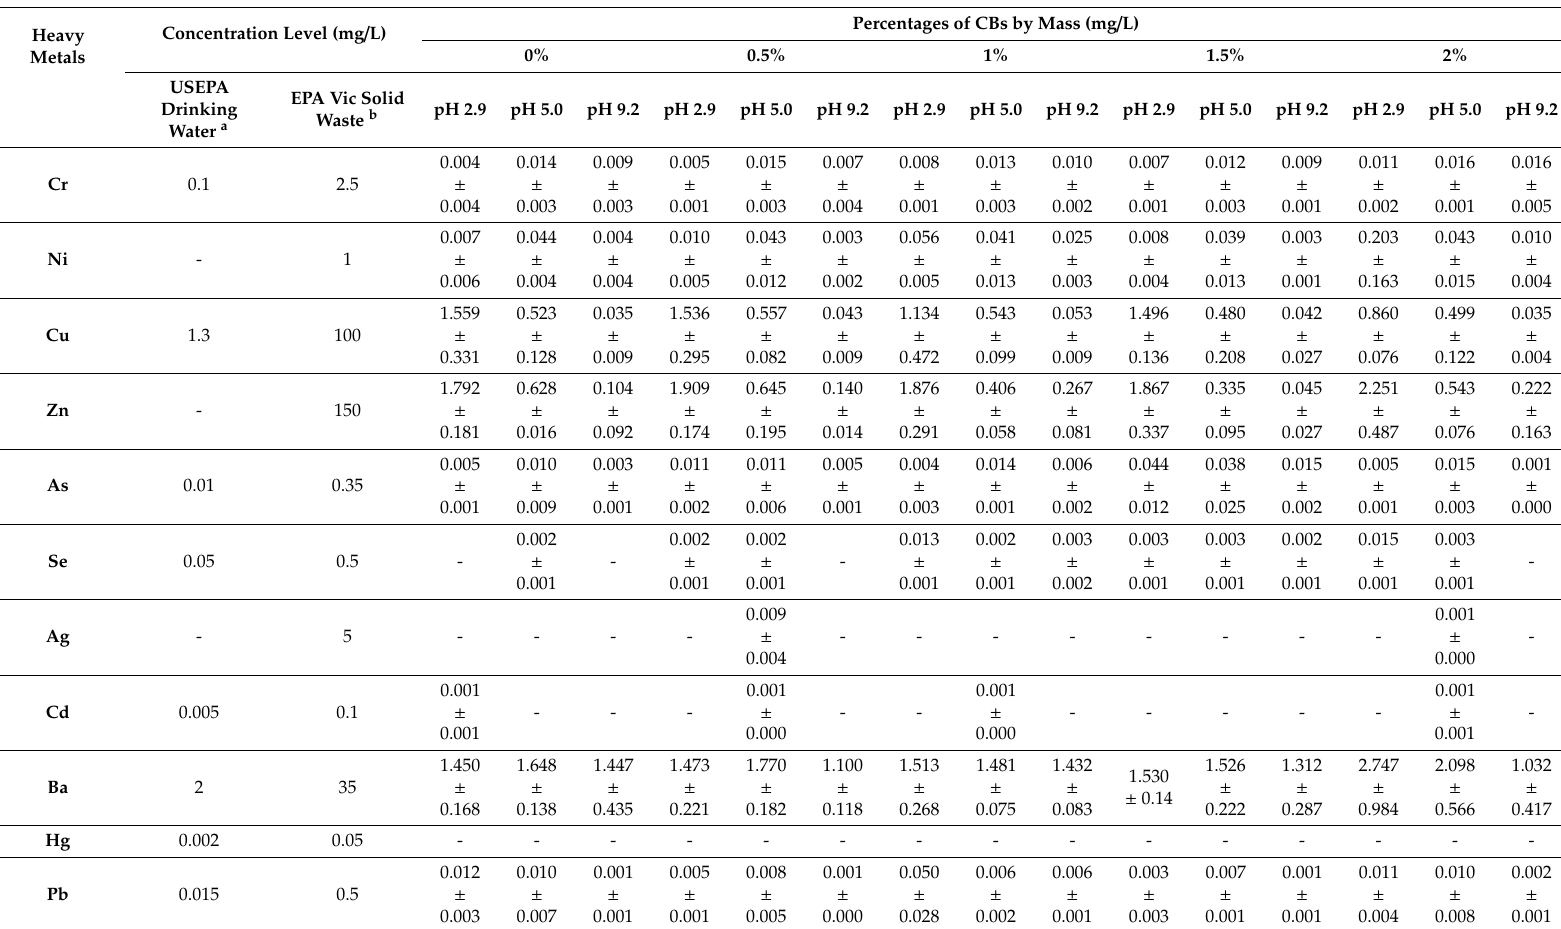
Table 3. Australian Bottle Leaching Procedure (ABLP) ( < 2.4 mm) leachate results for heavy metals in crushed brick samples using inductively coupled plasma mass spectrometry